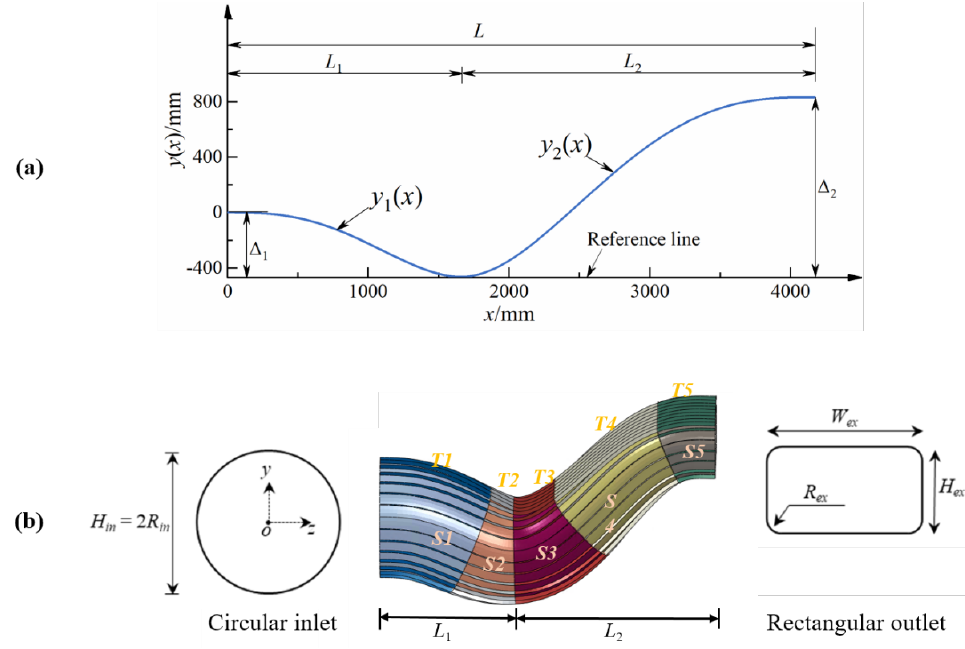
Figure 4. Geometric parameters of the S-shaped curved stiffened shell structure: ( a ) reference line, and ( b ) cross-section along the reference line.